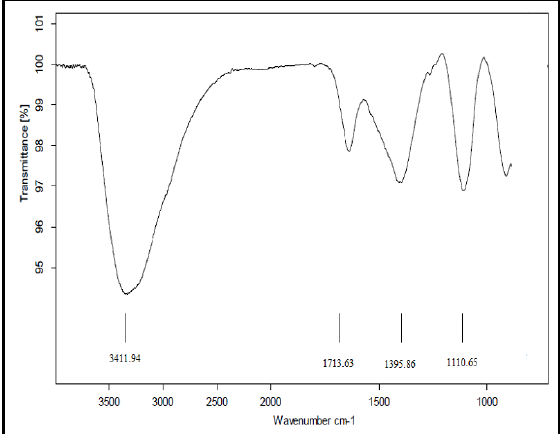
Figure 1. Attenuated total reflectance fourier transform infrared spectroscopy (ATR-FTIR) spectrum of the prepared graphene oxide (GO)